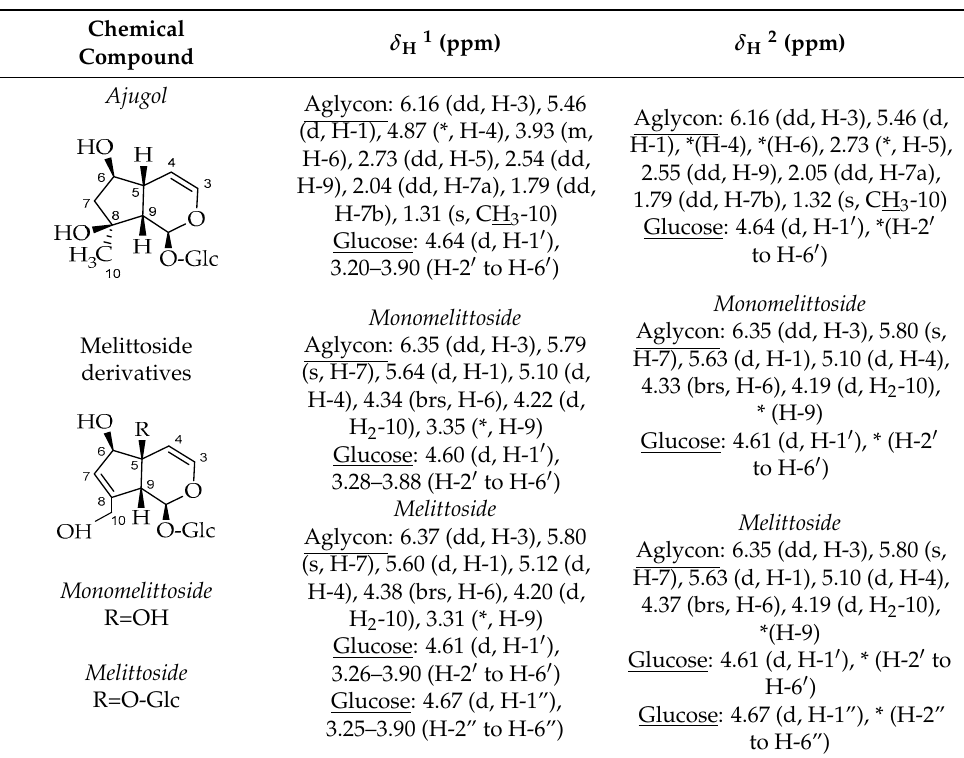
Figure 5. The overlaid 1 H-NMR spectra of the infusion of S. perfoliata subsp. perfoliata and of 4 ′ - methyl-isoscutellarein 7-O-[6’’’-O-acetyl]- β -D-allosyl(1 → 2)glucoside.